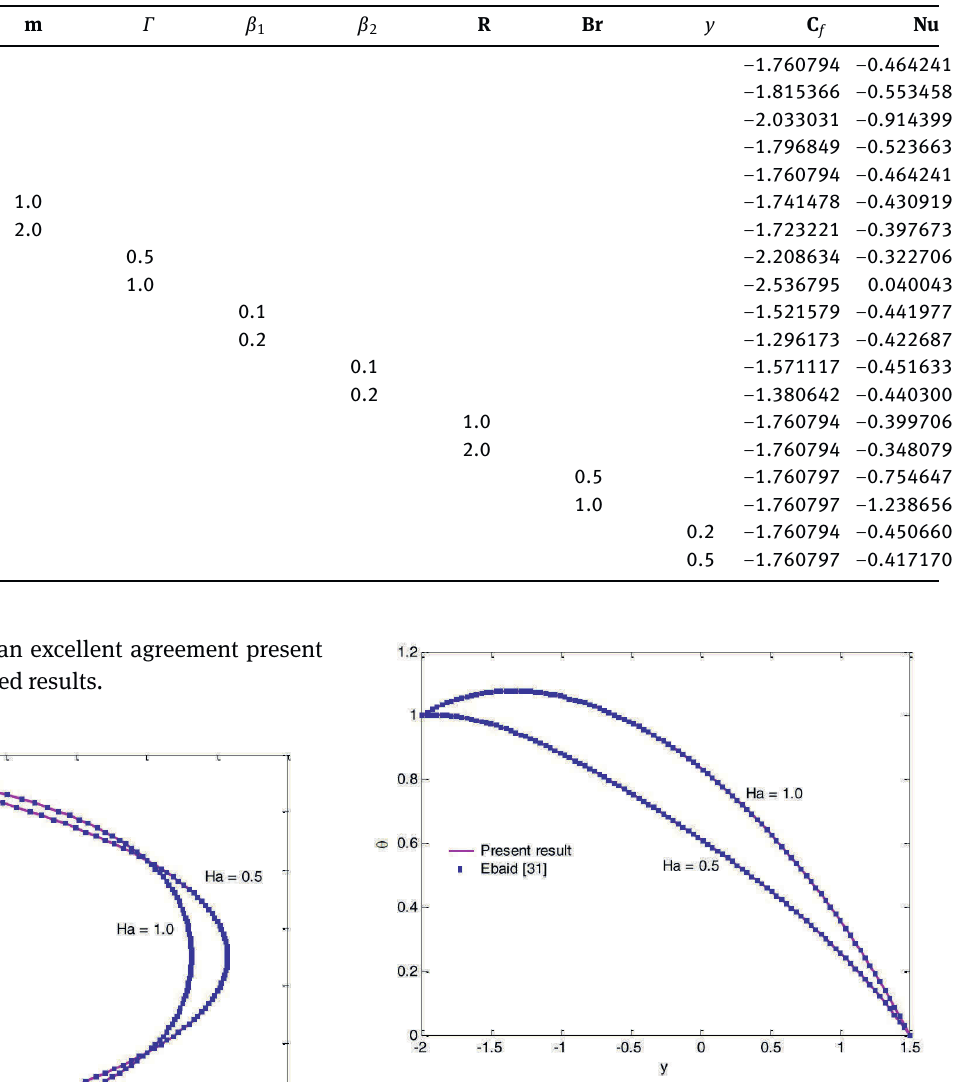
Table 2: The computational values of skin friction and heat transfer coefficients for the distinct sundry parameters at upper wall h 1 of the channel.